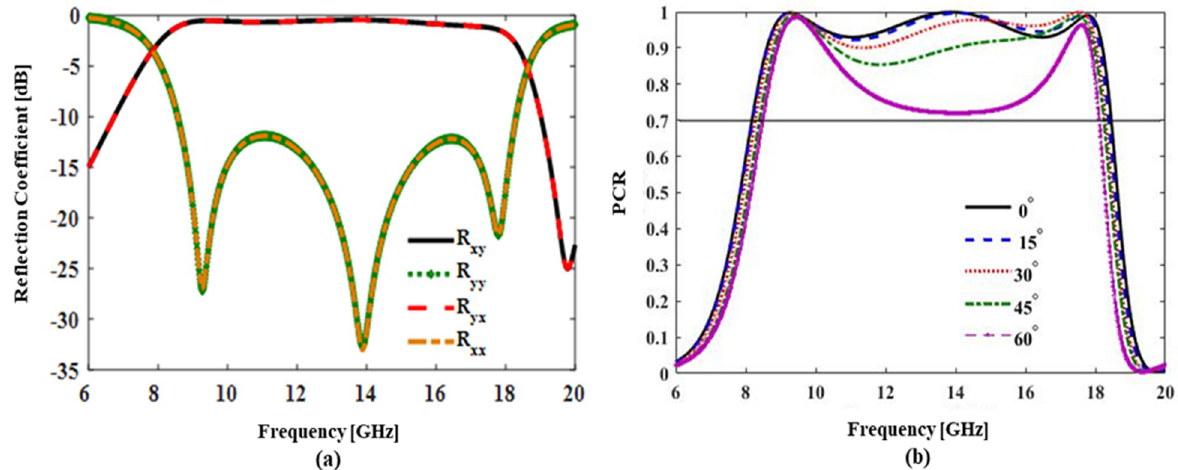
Fig 3. (a) Magnitude of Cross- and Co-polarized reflection coefficients for both x - and y -polarized incident waves (b) Polarization Conversion Ratio (PCR) results under normal and oblique incidences.